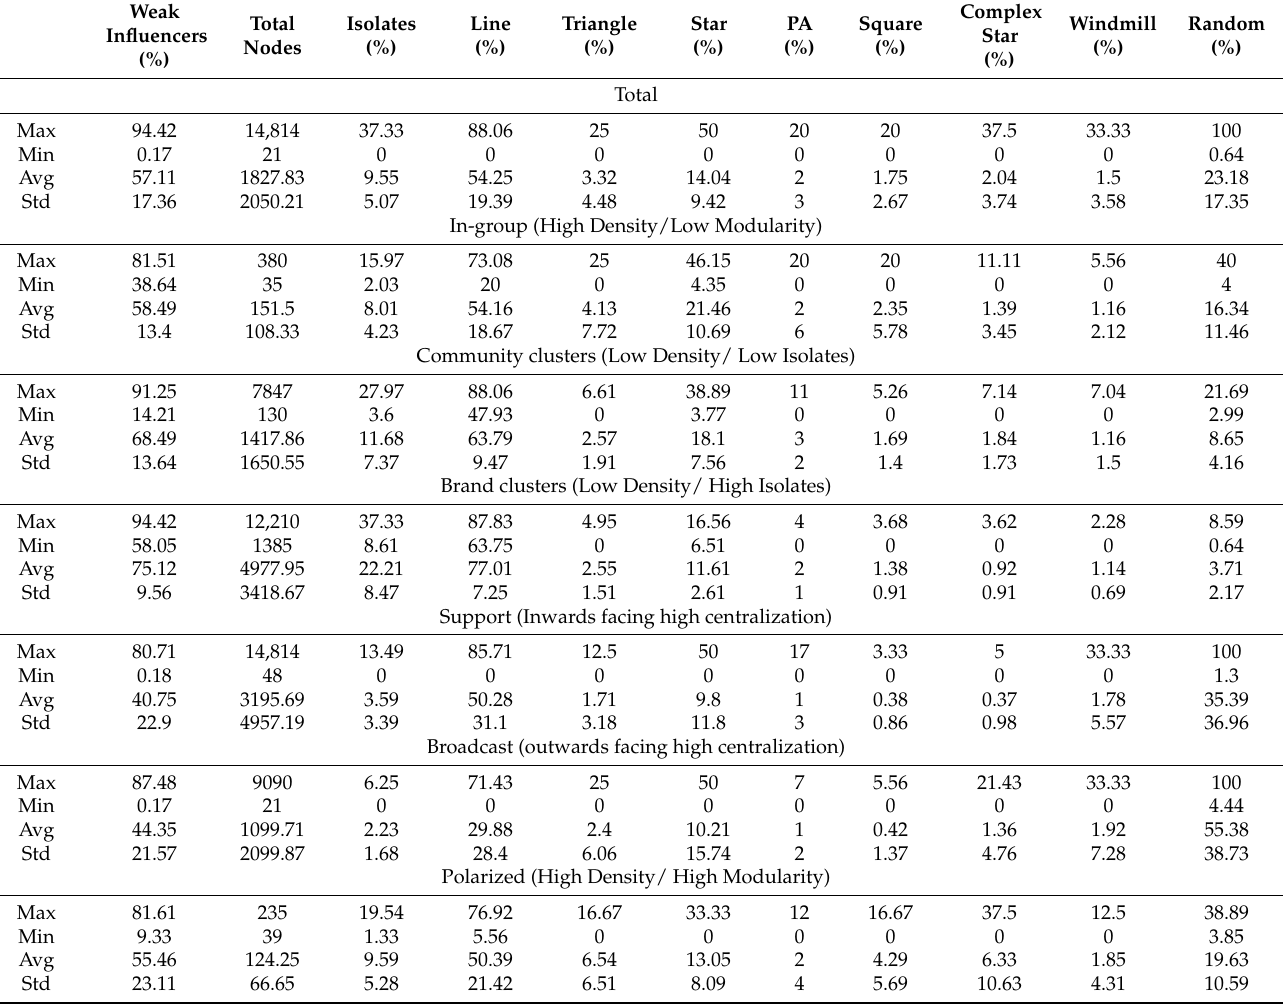
Table 2. Results of cluster analysis and their repetition across different topic topologies. Weak